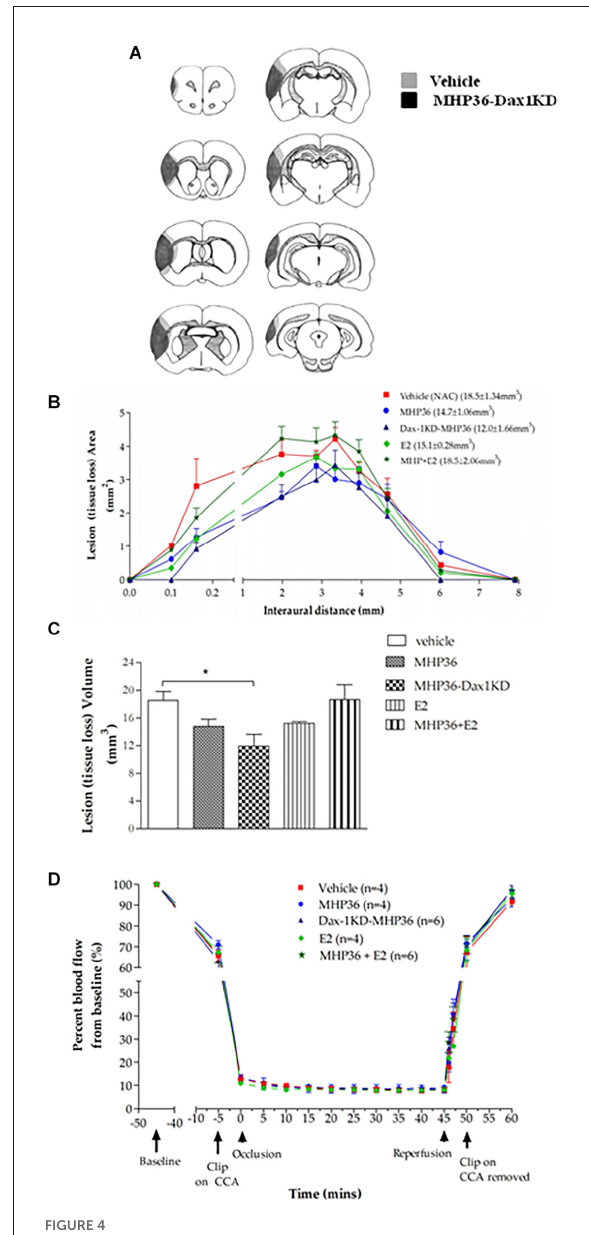
FIGURE4 MHP36-Dax1KD grafts reduced lesion size at 28 days post-MCAO with no differences in cerebral perfusion at the time of MCAO. (A) Median representatives of the topography of lesion in animals receiving either vehicle or MHP36-Dax1KD represented as shaded area on line diagrams of eight coronal levels. (B) Graphical representation of the topography of lesion over the eight coronal levels. (C) Bar graph representing lesion volumes measured in all experimental groups. A significant decrease in lesion volume was observed between MHP36- Dax1KD and vehicle treated ( ∗ p < 0.01, one-way ANOVA, post-hoc Bonferroni’s test to correct for multiple comparisons). (D) Cortical blood flow before, during and after MCAO, using laser Doppler flowmetry, presented as a percentage change from baseline blood flow (100%) (CCA = common carotid